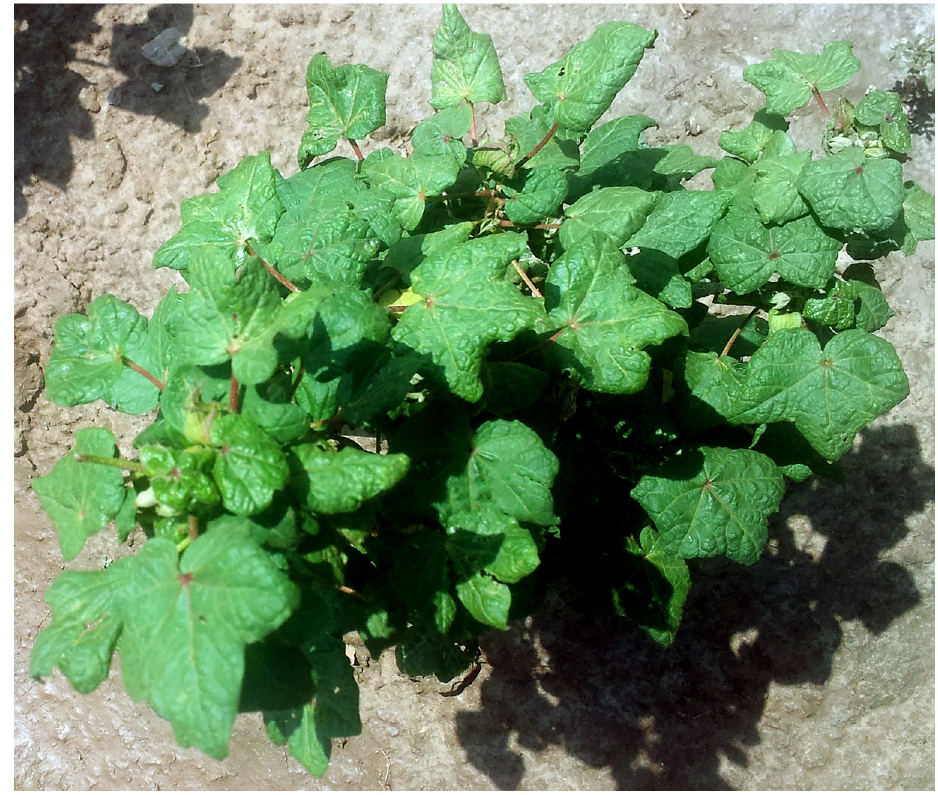
Fig 1. Cotton ( Gossypium hirsutum ) plant exhibiting typical symptoms of cotton leaf curl disease.